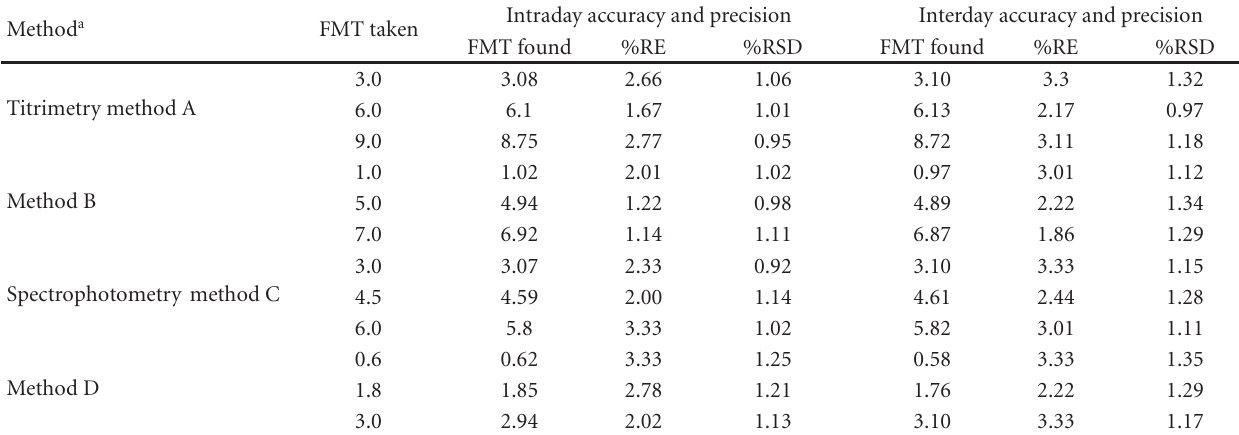
Table 3: Evaluation of intraday and interday accuracy and